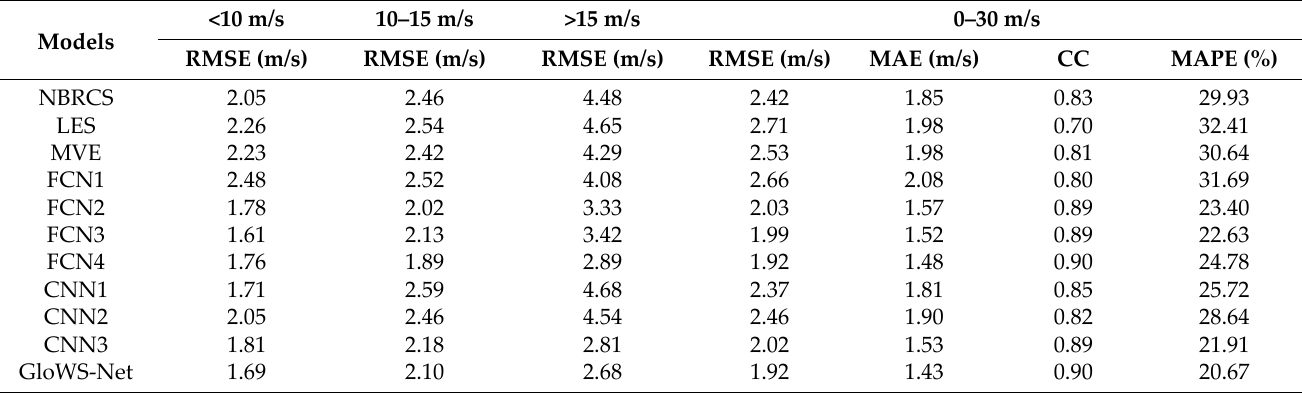
Table 5. Accuracy of wind speed retrieved from different models using ERA5 data as